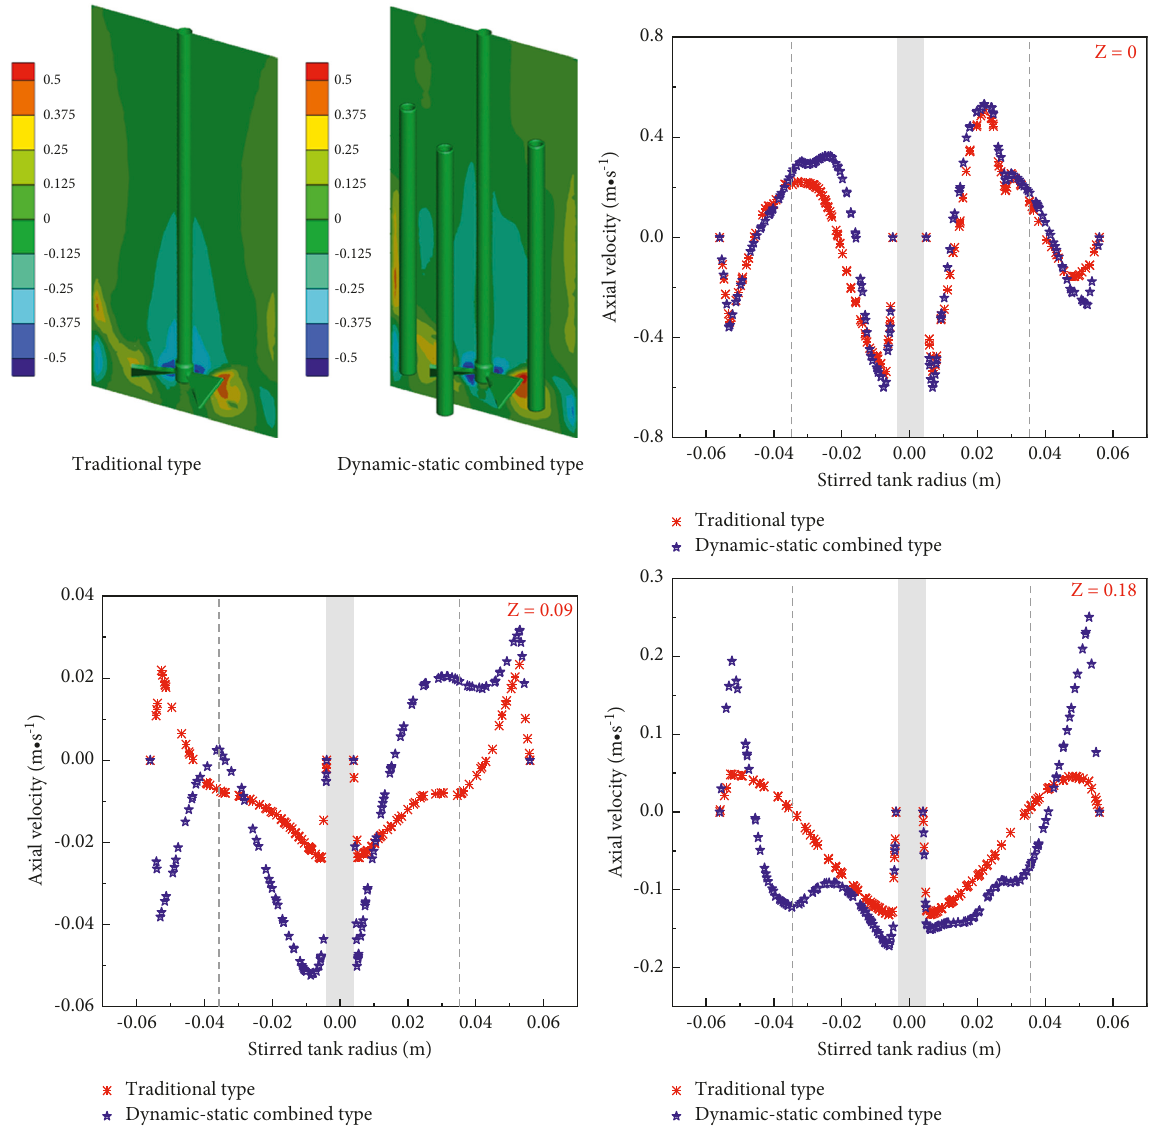
Figure 9: The axial velocity distribution at different planes ( Z � 0, Z � 0.09, Z �